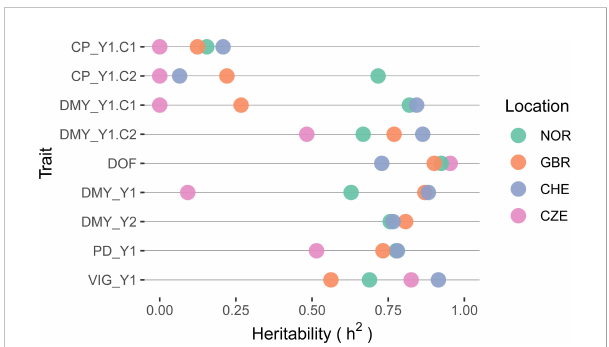
FIGURE 6 Heritability of selected traits within red clover fi eld trials per location. Traits are crude protein content (CP), dry matter yield (DMY), date of fl owering (DOF), plant density in autumn (PD) and plant vigor (VIG). Extensions _Y1 and _Y2 denote the fi rst and second main year of observation, .C1 and .C2 the fi rst and second cut per year, respectively. If the cut number is not speci fi ed, average values for VIG and sum of values for DMY over one year were